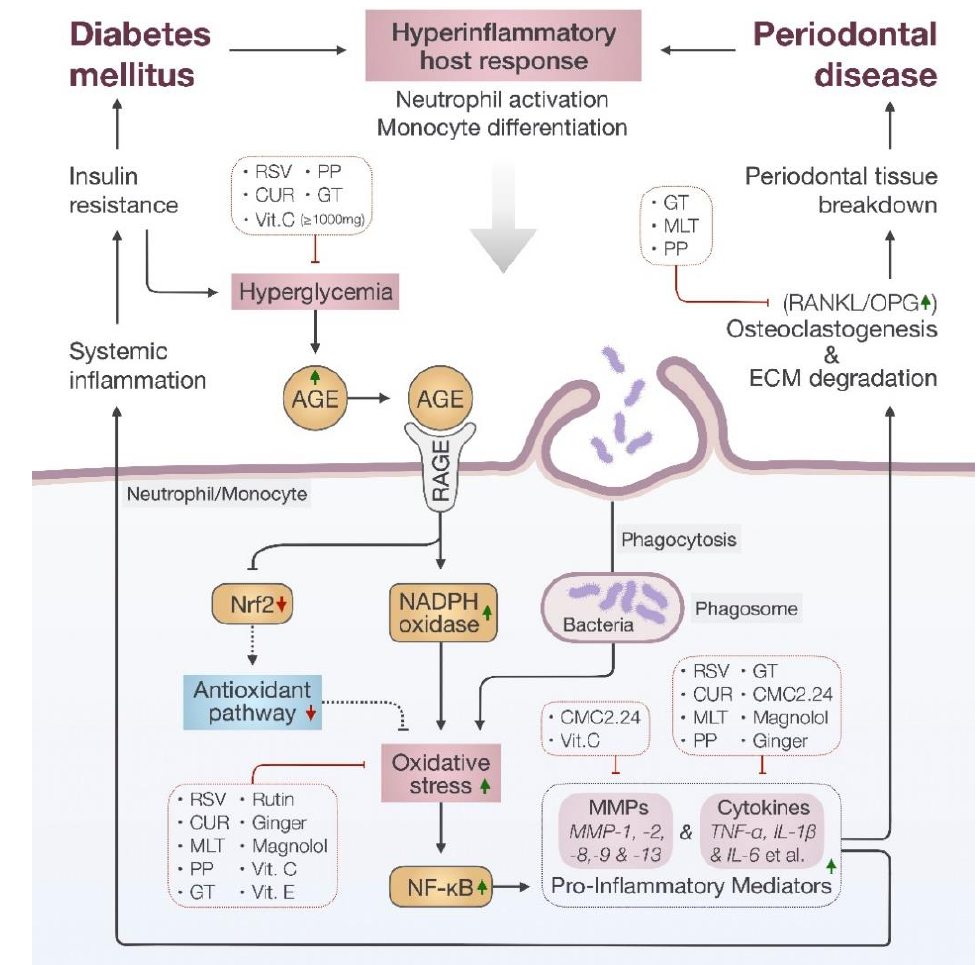
Figure 2. Summary of the pathogenesis of diabetes-associated periodontitis (DP). Table 1. Summary of study types for each natural compound and its clinical evaluation.